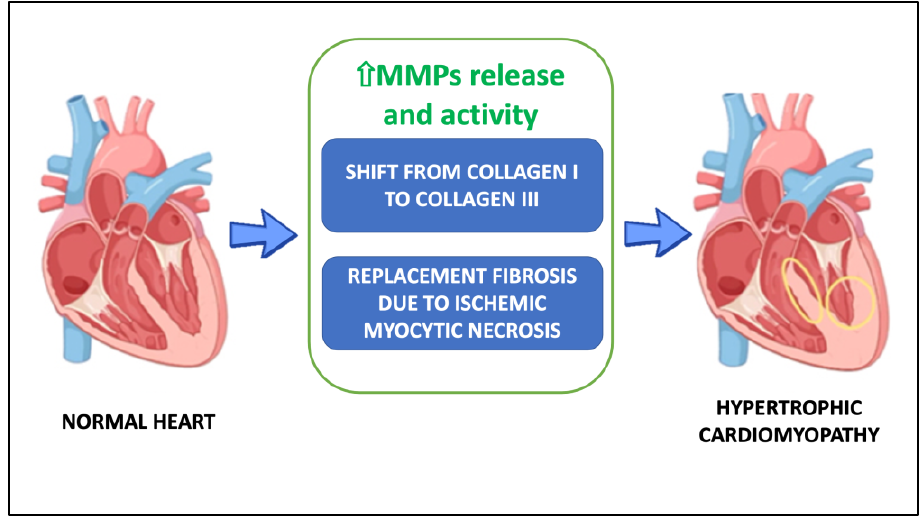
Figure 1. Potential mechanisms underlying hypertrophic cardiomyopathy. Abbreviations: MMPs, metalloproteinases.